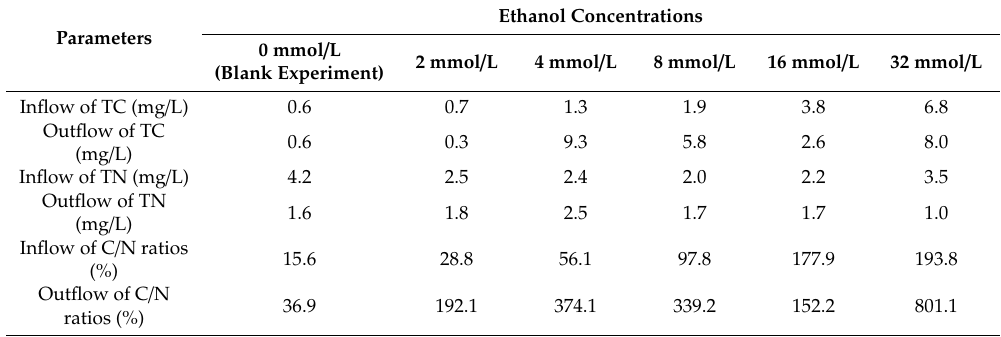
Table 3. The total carbon to total nitrogen (C / N) ratio driven by di ff erent ethanol in the IVCW.